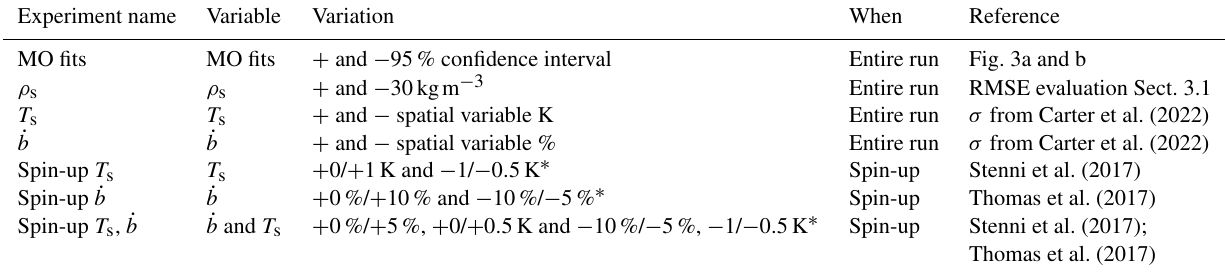
∗ The values on the left side of the slash indicate the variation for the Antarctic Peninsula and Ellsworth Land and the values on the right side of the slash for the remainder of the AIS. Temperature and accumulation over the Antarctic Peninsula and Ellsworth Land are the second-to-last loop of spin-up reduced by 6.66% and 0.66K and in the last loop with 3.33% and 0.33K; see main